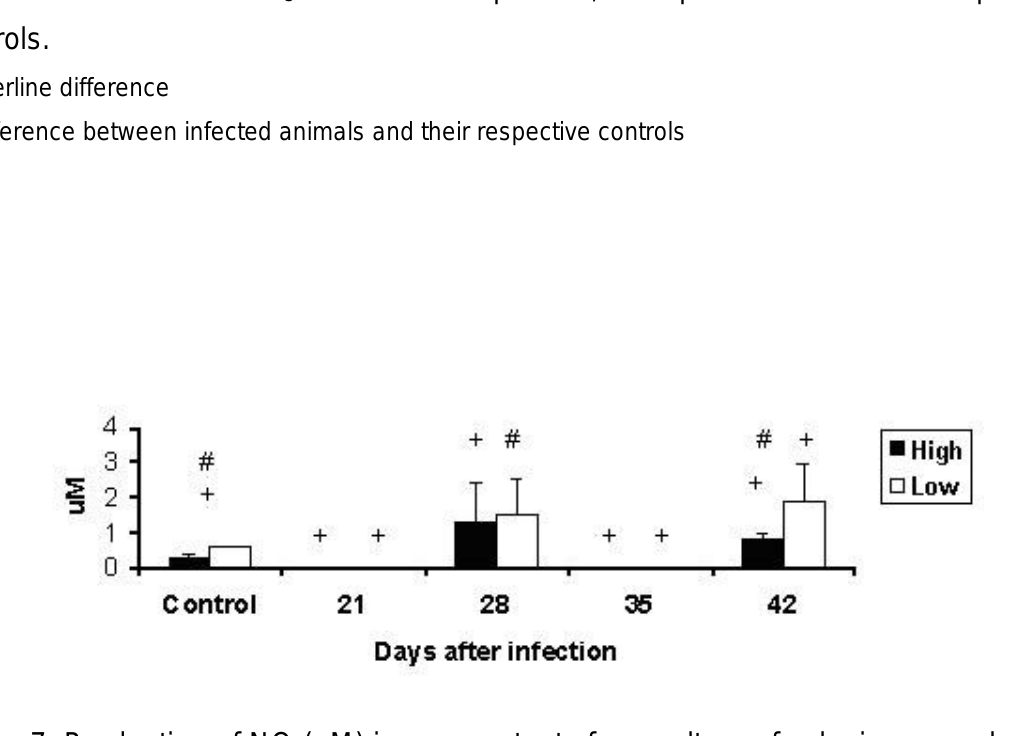
Figure 7. Production of NO ( μ M) in supernatants from culture of splenic macrophages of High and Low antibody producer (Selection IV-A) mice infected with Mycobacterium bovis- AN at different periods, compared with their respective 5